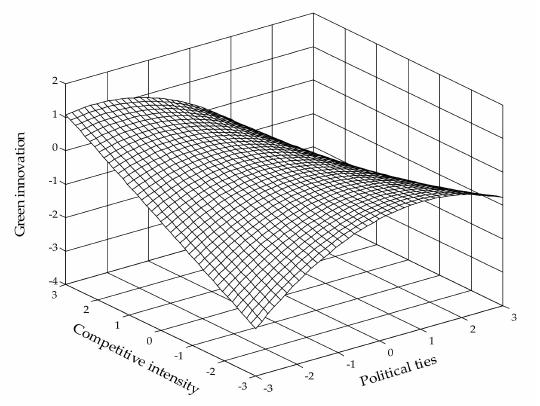
Figure 4. Moderating effect of competitive intensity on the relationship between political ties and green